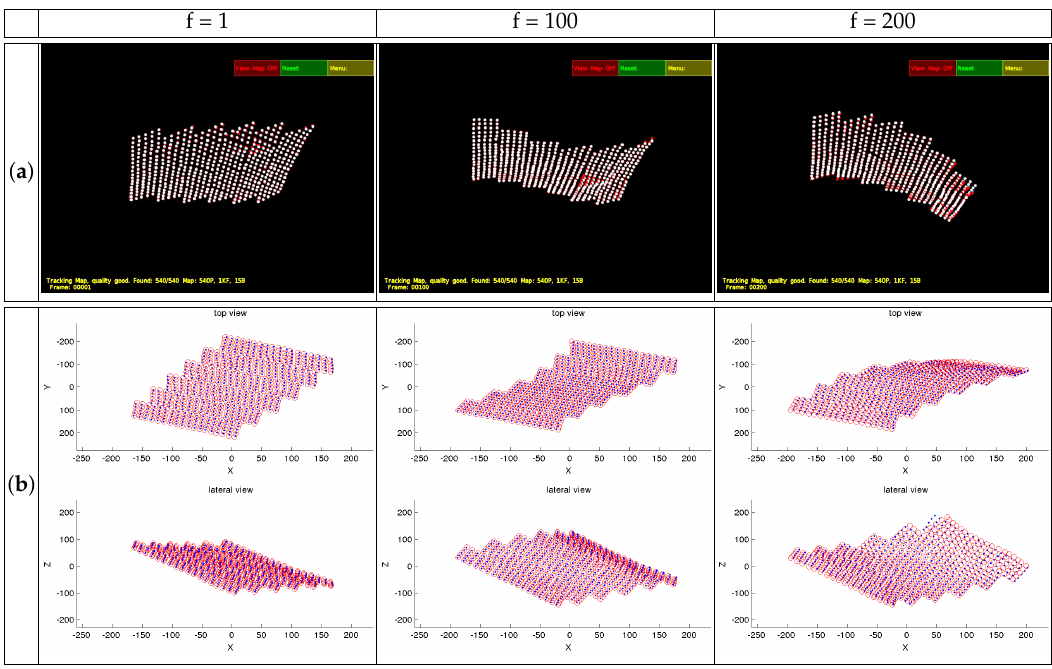
Figure 3. Flag sequence snapshots ( a ) and reconstruction results ( b ) for certain frames.